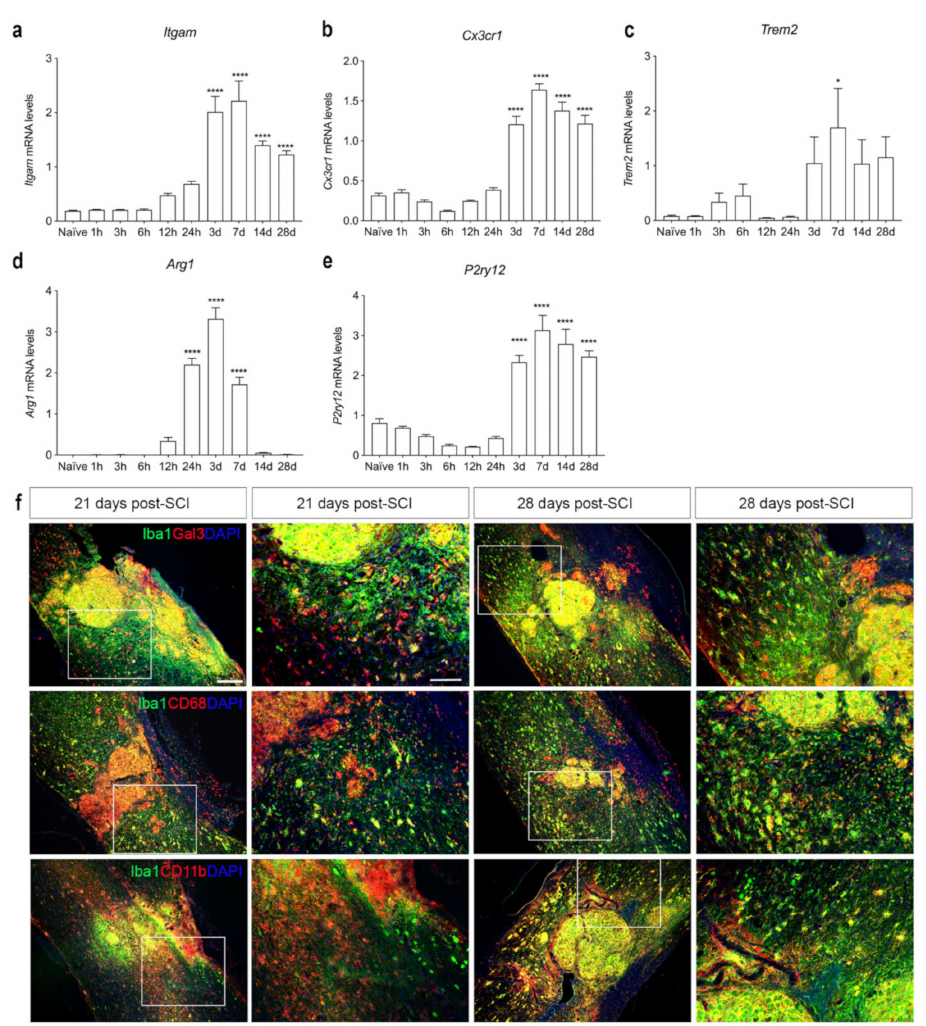
Figure 7. Characterization of microglia/macrophage reactions after SCI. ( a – e ) Temporal expression of Itgam (( a ), Time: F 9,38 = 30.97, p < 0.0001), Cx3cr1 (( b ), Time: F 9,38 = 77.32, p < 0.0001), Trem2 (( c ), Time: F 9,37 = 3.218, p = 0.006), Arg1 (( d ), Time: F 9,39 = 113.6, p < 0.001), and P2ry12 (( e ), Time: F 9,38 = 48.17, p < 0.001) mRNA levels after SCI. Results are presented as mean ± SEM, n = 5/group, * p < 0.05 and **** p < 0.0001. ( f ) Immunofluorescence double labeling of Iba1 + (green) and Gal3 + (red, upper panel), CD68 + (red, middle panel), or CD11b + (red, lower panel) cells at 21 and 28 days after SCI. High magnification images represent squared areas in the low magnification images. Scale bars: low magnification = 100 µ m and high magnification = 40 µ m. CD, cluster of differentiation; Gal3, galectin-3; Iba1, ionized calcium binding adaptor molecule 1.